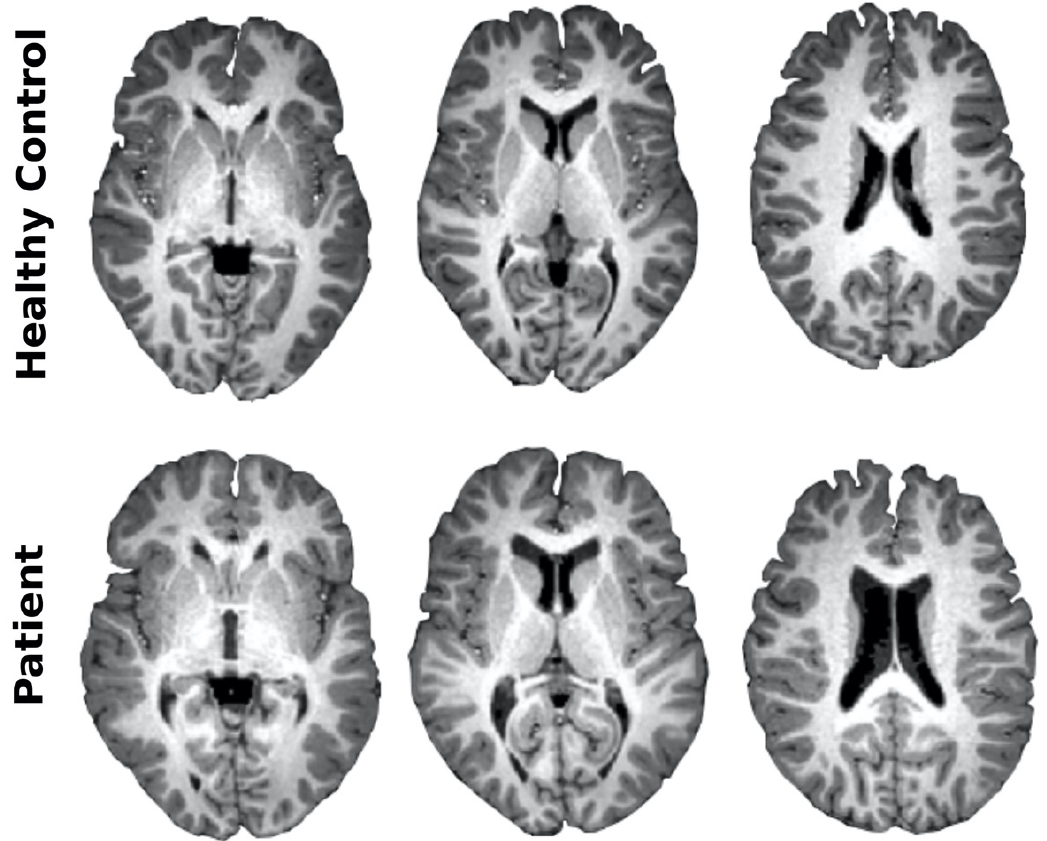
Figure 2. Large increased ventricular volume in combined Cobalamin D disorder. After acquiring structural brain images from both the healthy control and the patient with combined cblD disorder, the ventricular volume increased a proportion of 254%. Here, the same axial slices are shown for both healthy control and patient.